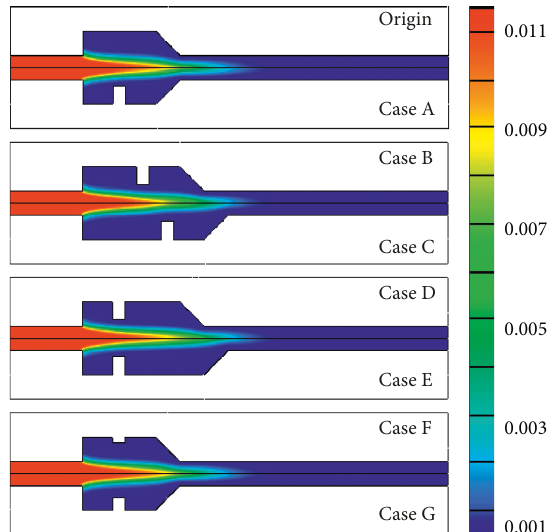
Figure 10: Radical H 2 distribution in the different combustors; inlet velocity is 10